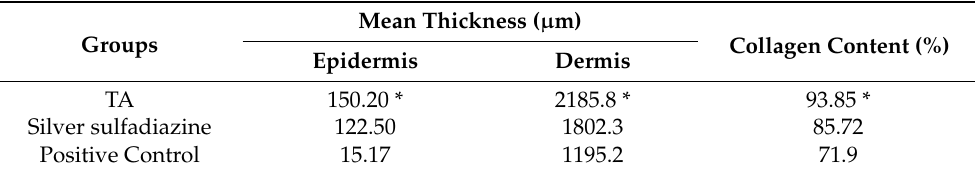
Table 9 Mean thickness of epidermis and dermis (µm), and collagen content percentage (%), * TA proved as significant ( p < 0.05) statistically.